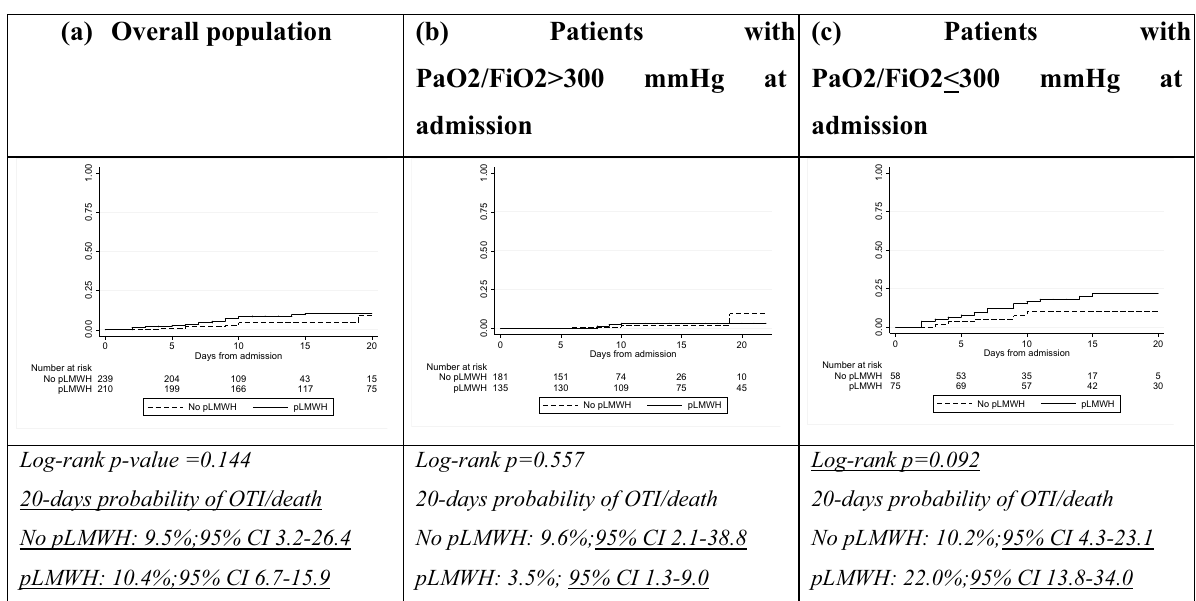
Figure 2. (a) Estimated probability of mechanical invasive oro-tracheal intubation/death (OTI/death) according to pLMWH exposure in the study population and stratified by PaO 2 /FiO 2 ratio at admission (b) > 300 mmHg and (c) ≤ 300 mmHg. pLMWH prophylactic low molecular weight heparin, OTI/death oro- tracheal